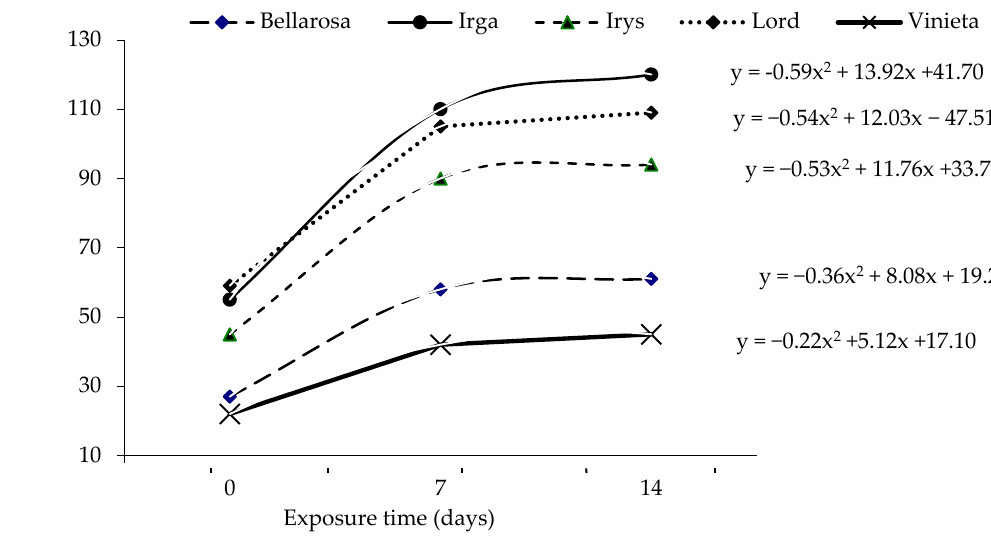
Figure 2. Equations of the relationships between the time of exposure to light and the content of glycoalkaloids in washed tubers of the tested varieties (mg·kg -1 FM).